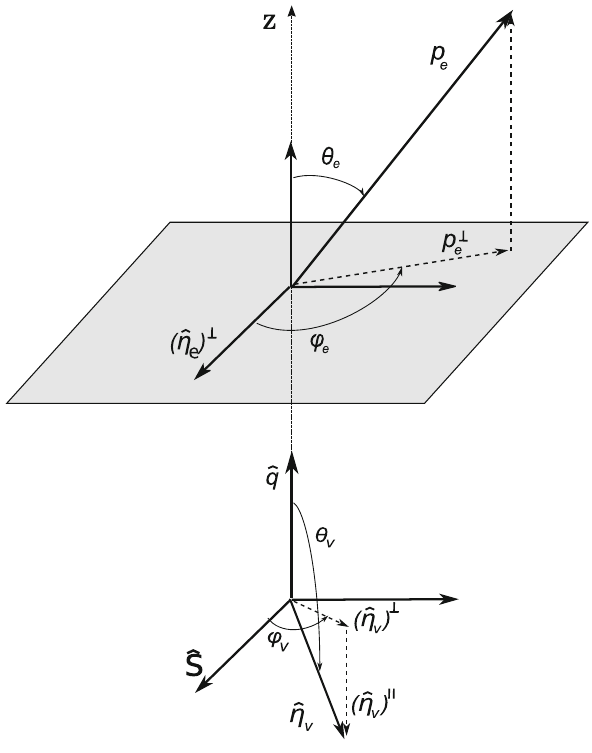
Fig. 1 The production plane of the ν e beam is spanned by the polar- ization unit vector ˆ S of source and the ν e LAB momentum unit vec- tor ˆ q . The reaction plane is spanned by ˆ q and the transverse electron polarization vector of target ( ˆ η e ) ⊥ (due to ˆ η e ⊥ ˆ q ) for ν e + e − → ˆ q and the unit vector ˆ p ν + e − . θ e e is the polar angle between e of recoil electron momentum. φ e is the angle between ( ˆ η e ) ⊥ and the transversal component of outgoing electron momentum ( ˆ p e ) ⊥ . ˆ η ν = ( sin θ ν cos φ ν , sin θ ν sin φ ν , cos θ ν